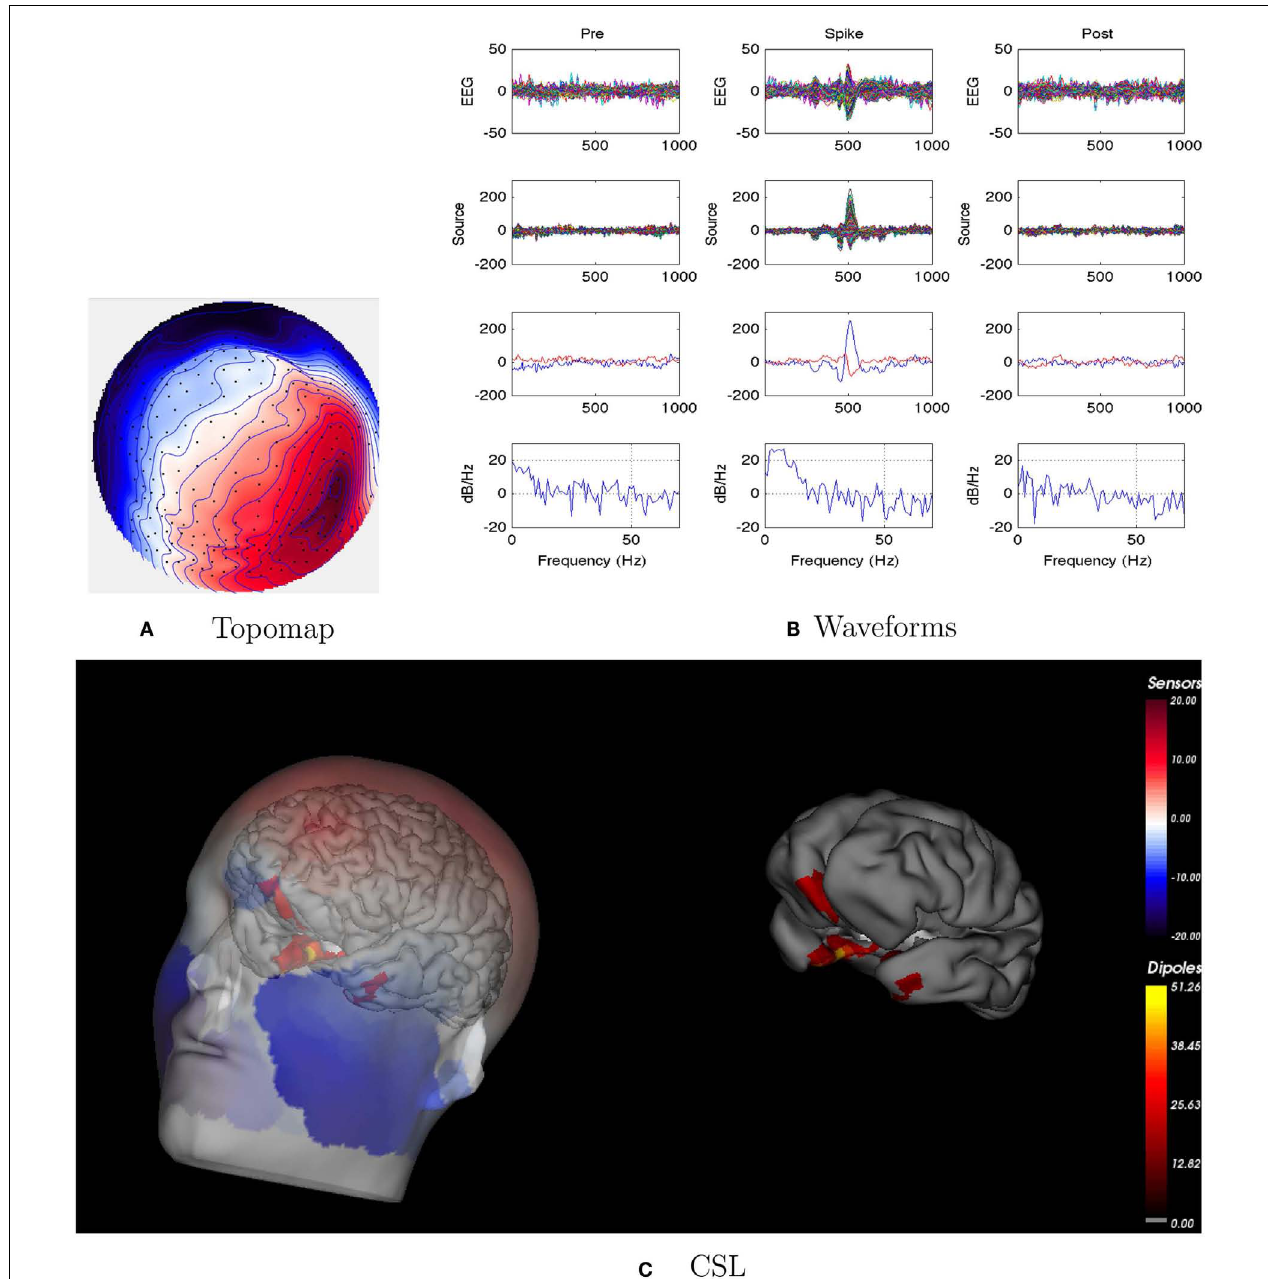
the frequency spectra of the blue source waveforms (third row) shown in forth row. Note that the dipole location of the blue trace is in the left temporal lobe and the magenta trace in the third row is in the right anterior temporal lobe, consistent with the icEEG data and resection zone. In (B) , each column represents 1s of data from a 3-s segment. Middle column represent data centered on the spike peak. (C) Electrical source localization with the patient’s individual electrical head model. Left: scalp potential reconstructed from the source estimate (at 50% of spike peak). Right: partially inflated brain illustrating the dominant source associated with the data illustrated in left figure (location of dipole described by magenta trace in (B) , third row). Data was thresholded to only show top 5%